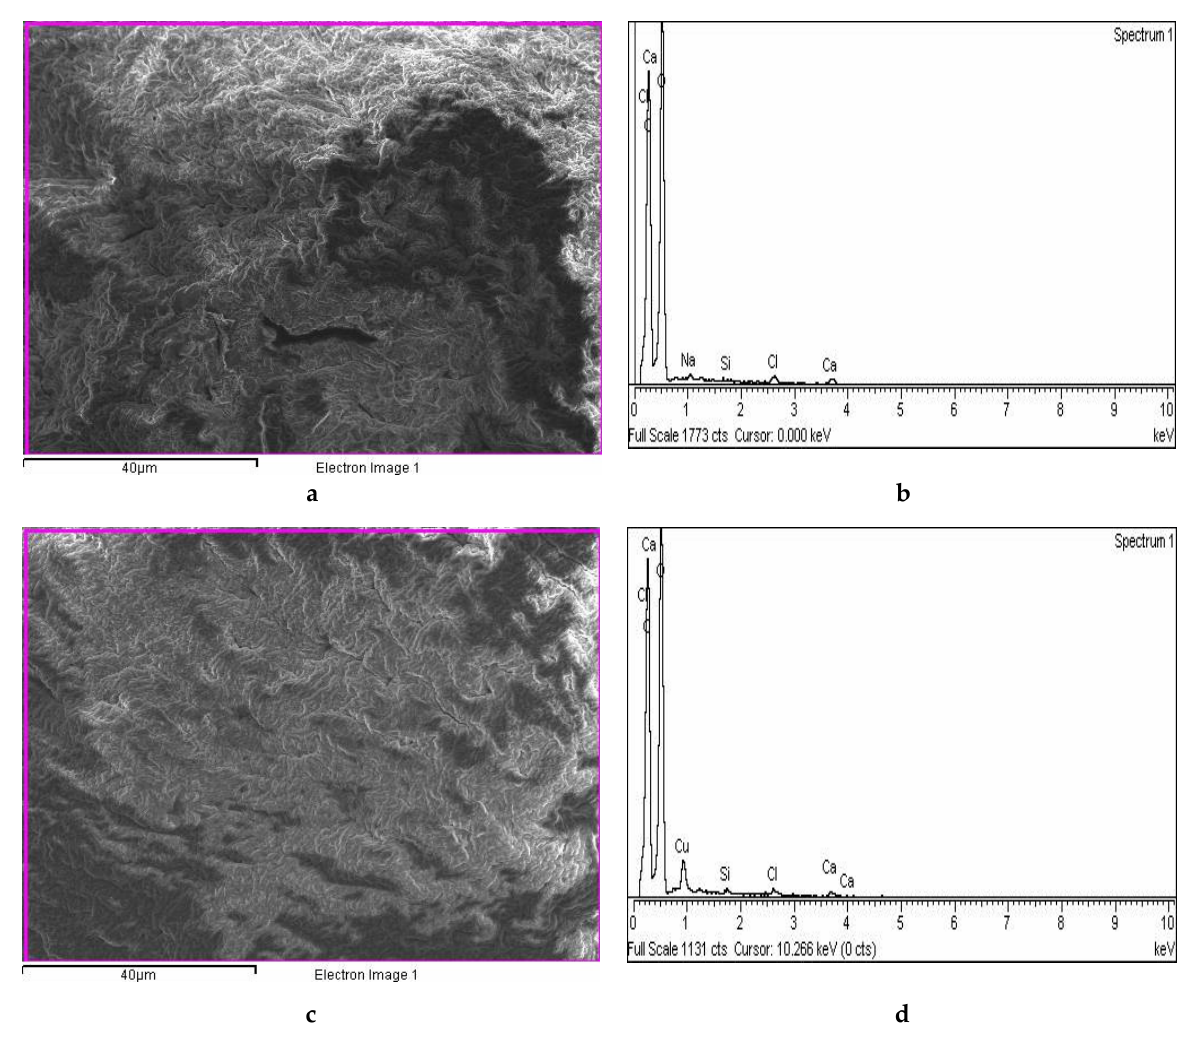
Figure 3. Scanning electron microscope images of CS/(ALG/Ca) ( a , b ) and CS/(ALG/Ca+Cu)) ( c , d ) dried microcapsules. Bars are indicated.